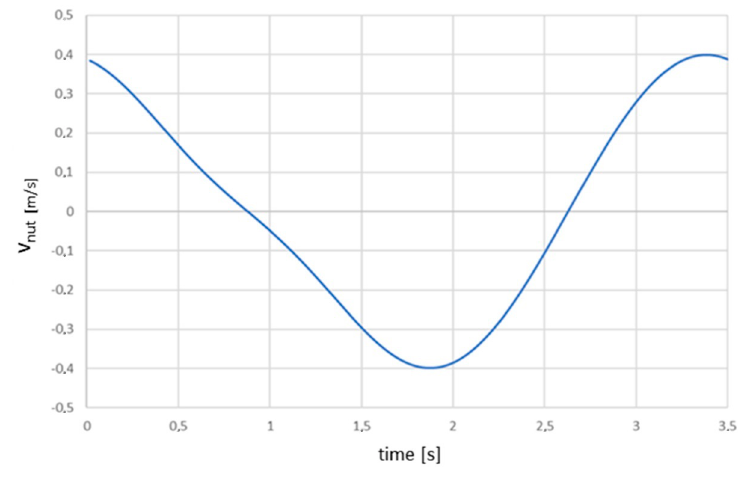
Figure 13. Nut velocity v nut as a function of time. The EHL model provided film parameters λ and coefficients of friction f , shown in Figure 14, and referred to each component mentioned above.